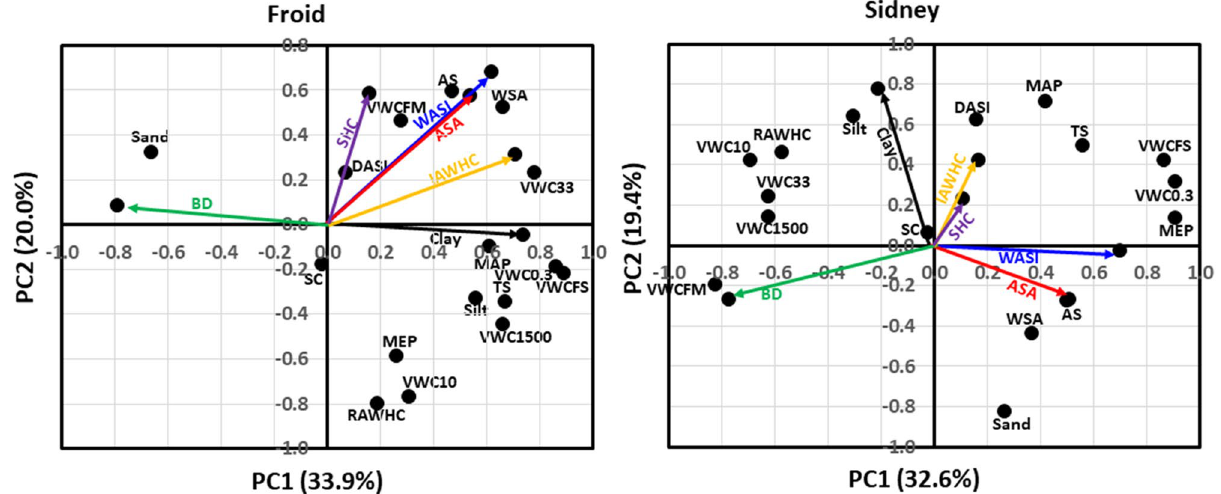
Figure 1. Principal component analysis for the associations among average slake aggregate (ASA), bulk density (BD), clay concentration, intact core available water capacity (IAWHC), saturated hydraulic conductivity (SHC), wet aggregate stability index (WASI), and soil physical properties at Froid and Sidney, MT. At Froid, soil physical properties explained 33.9% of the total variability in the first principal component (PC1) and 20.0% in the second principal component (PC2). At Sidney, physical properties explained 32.6% of total variability in PC1 and 19.4% of the total variability in PC2. AS denotes aggregate stability; DASI, dry aggregate stability index; MAP, macro-porosity; MEP, meso-porosity; RAWHC, repacked core available water capacity; SC, stone content; TS, total shrinkage; VWC0.3, volumetric water content at 0.3 kPa; VWC10, volumetric water content at 10 kPa; VWC33, volumetric water content at 33 kPa; VWC1500, volumetric water content at 1500 kPa; VWCFM, volumetric water content in the field-moist soil; VWCFS; volumetric water content at water saturation; and WSA, water-stable aggregation.